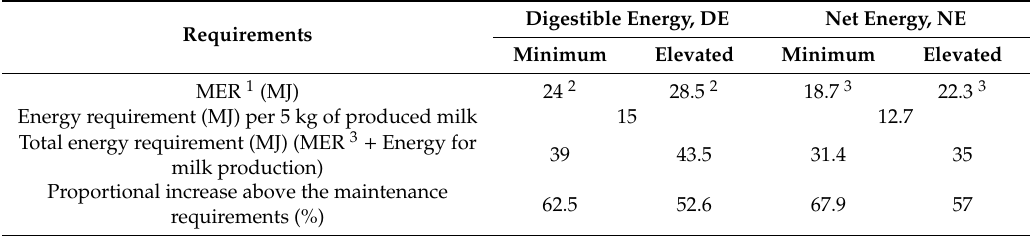
Table 2. Estimated digestible energy (DE) and net energy (NE) maintenance requirements for a lactating donkey (with a bodyweight (BW) of 300 kg and assuming a daily milk production of 5 L) with the proportional increase over the maintenance requirements (adapted from Smith and Burden [19] and Martin-Rosset